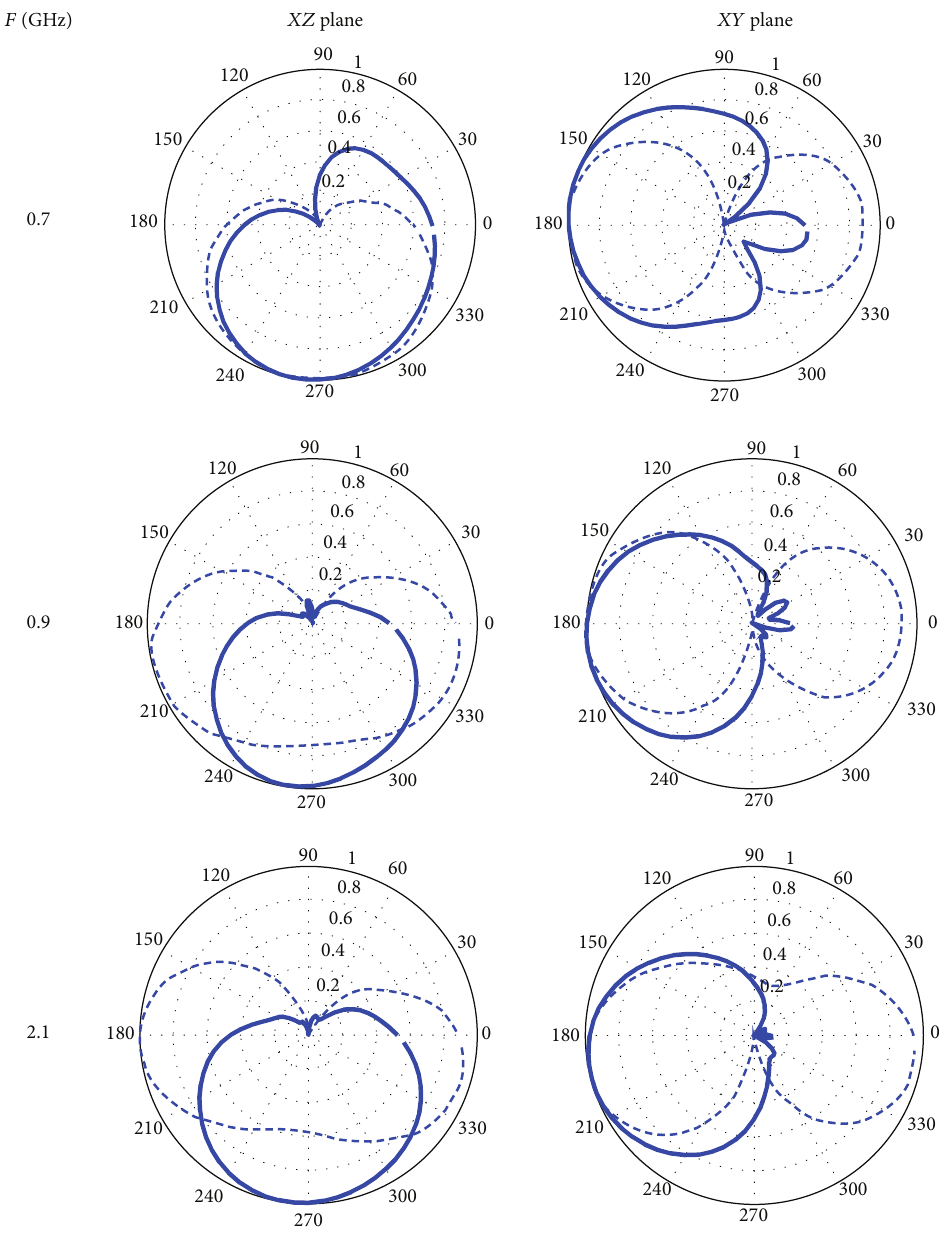
Figure 6: The simulated radiation pattern in the XZ and XZ planes. The antenna is in the YZ plane: without human body (Dash line); with human body (Solid